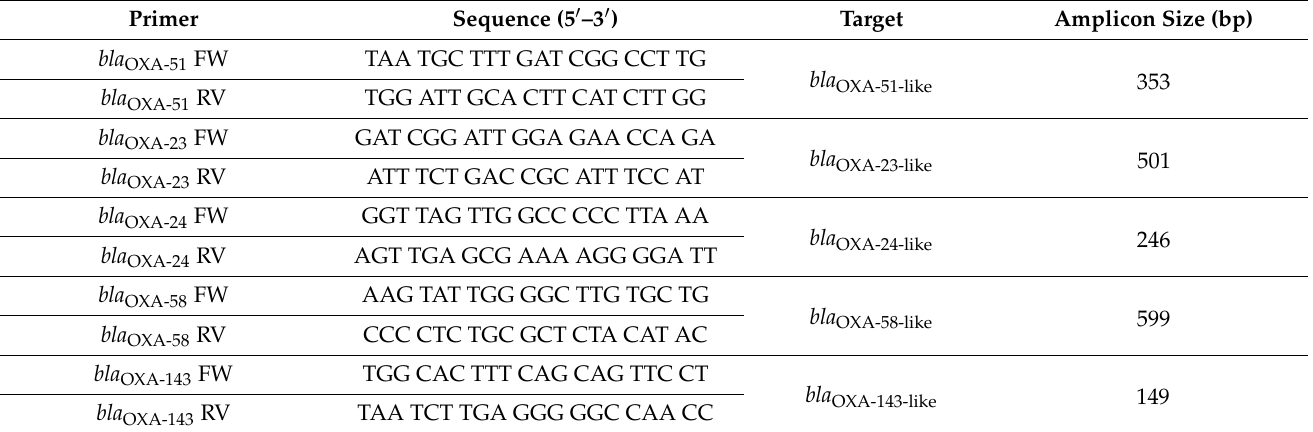
Table 2. Primers used for PCR amplification of oxacillinase resistance genes (bla OXA-like ).